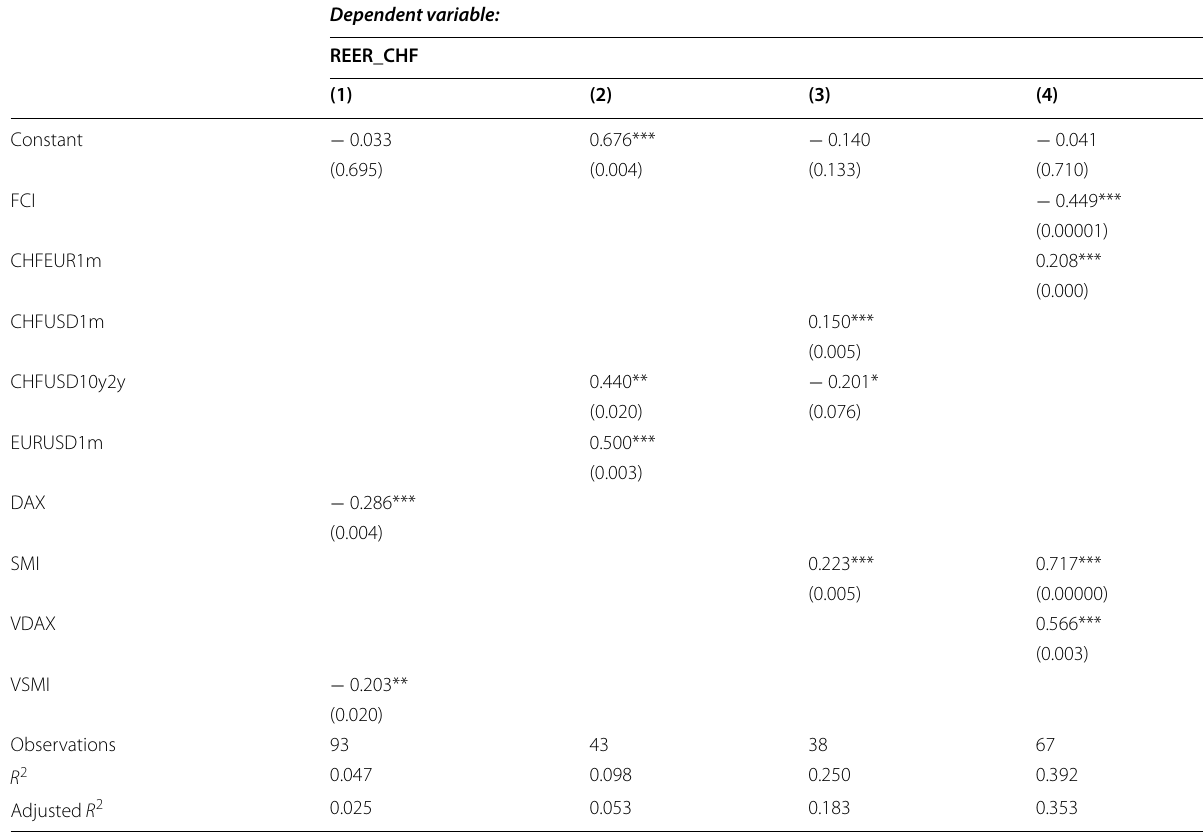
Table 10 Optimal OLS regression results across all